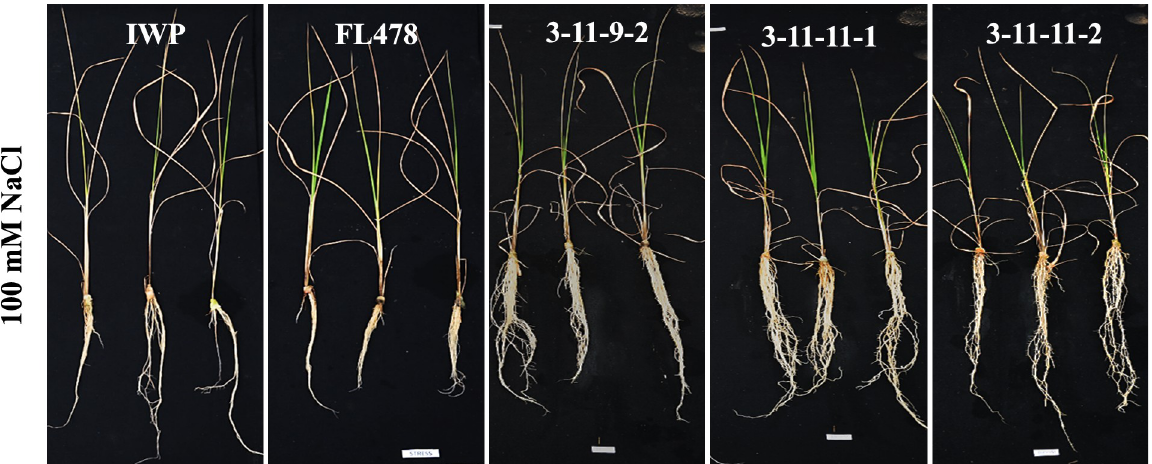
Fig 6. Performance of BILs and IWP against 100 mM NaCl stress under hydroponic conditions.